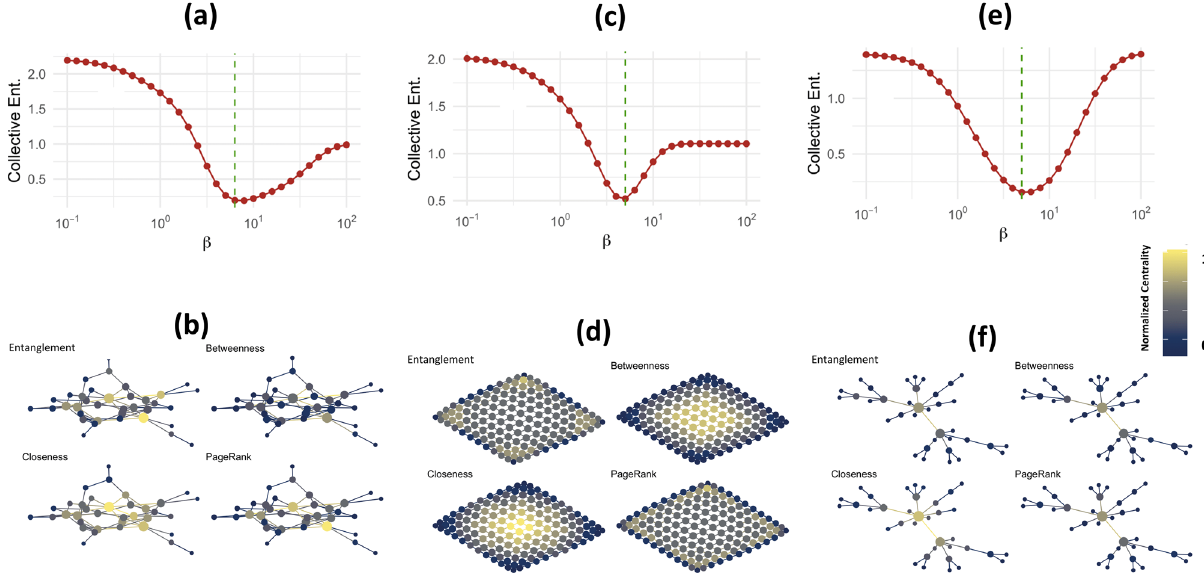
Fig. 6 Collective entanglement. Collective network entanglement M β as a function of the propagation time beta for ( a ) a regular lattice ( c ), an Erdos – Renyi, and ( e ) a Barabasi – Albert network. The green dashed line corresponds to the minimum collective entanglement and de fi nes the time-scale β c . Centrality of each node according to different measures (entanglement for β = β c , betweenness, closeness, and PageRank) for ( b ) the regular lattice ( d ) the Erdos – Renyi, and ( f ) Barabasi – Albert network. By comparing centrality measures on the same network one can see that it is evident that network entanglement is not trivially related to existing centrality